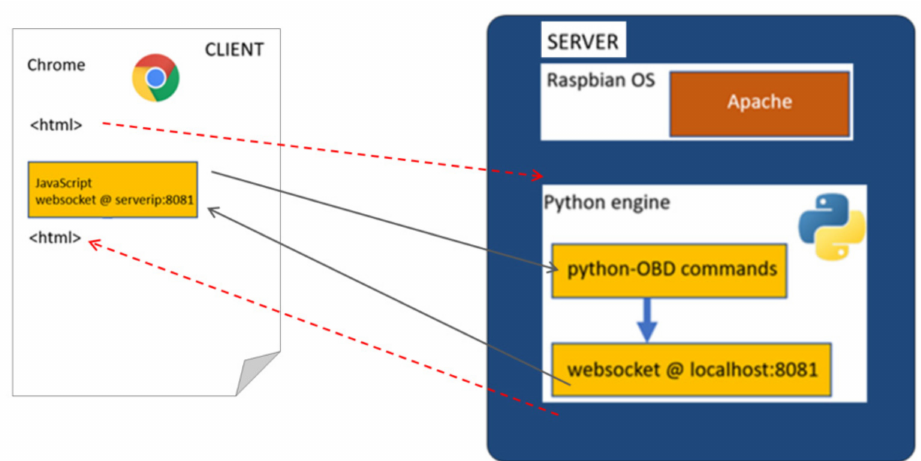
Figure 12. The application level architecture of the designed client server architecture.